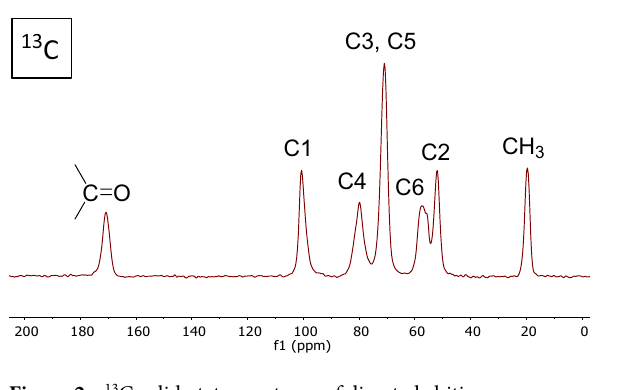
Figure 2. 13 C solid-state spectrum of digested chitin.